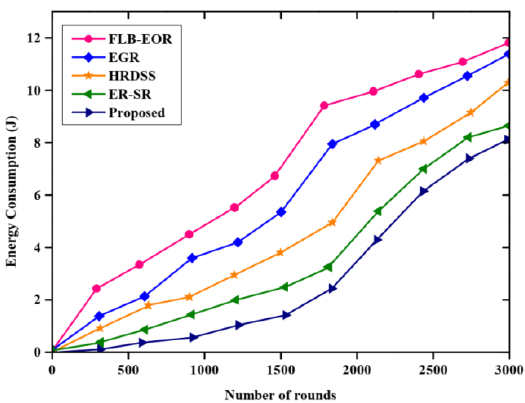
Figure 6. Comparative results of energy consumption.